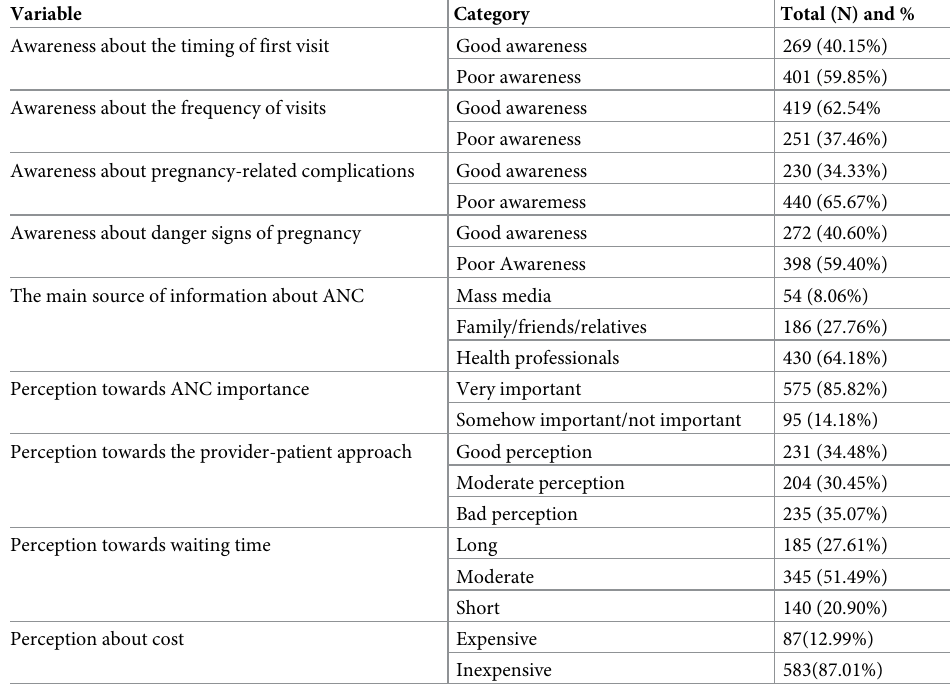
Table 3. Knowledge and perception of women about ANC service in Southern Ethiopia,